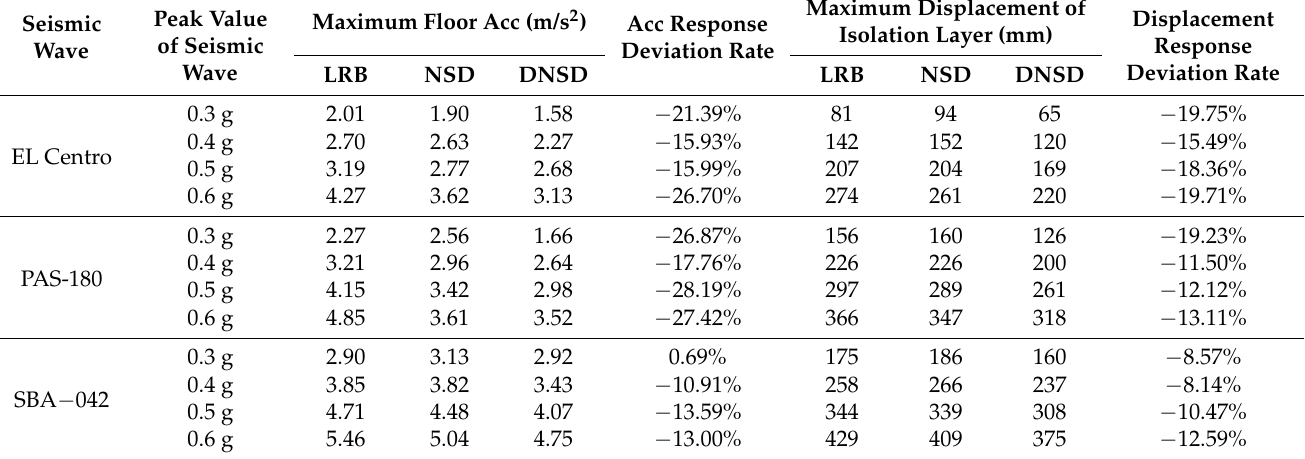
Table 3. Summary of time history results under the action of local seismic waves (LRB vs.